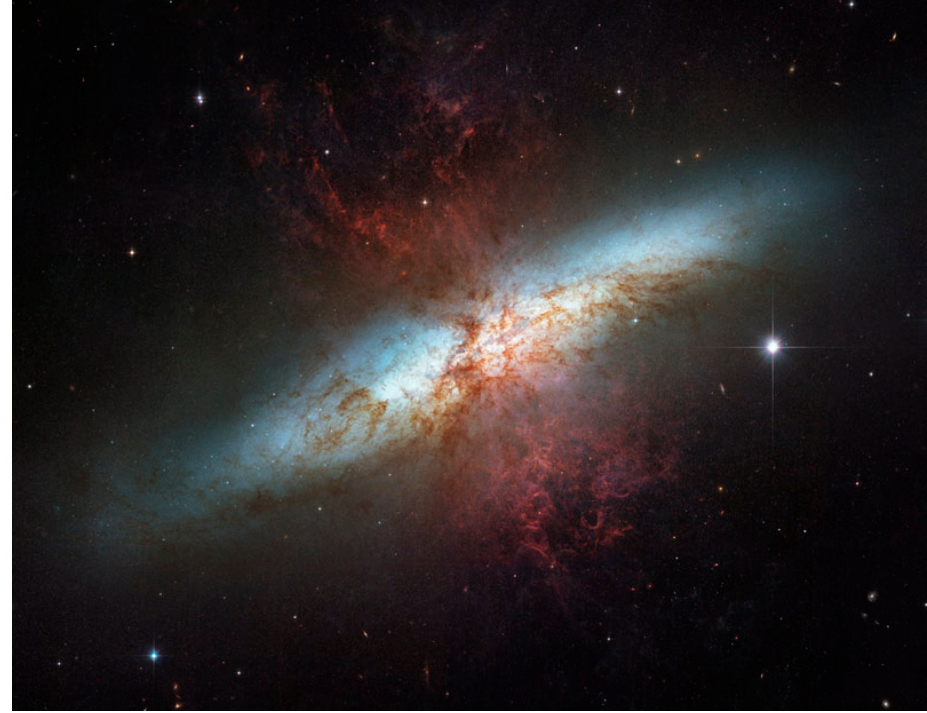
Figure 1. The H α image (red component) of galactic wind in M82. Figure from the Hubble telescope galley (http://hubblesite.org/image/1876/gallery). H α image credit is from FOCAS, Subaru 8.3-m Telescope, NAOJ, and the disk image is from the Hubble